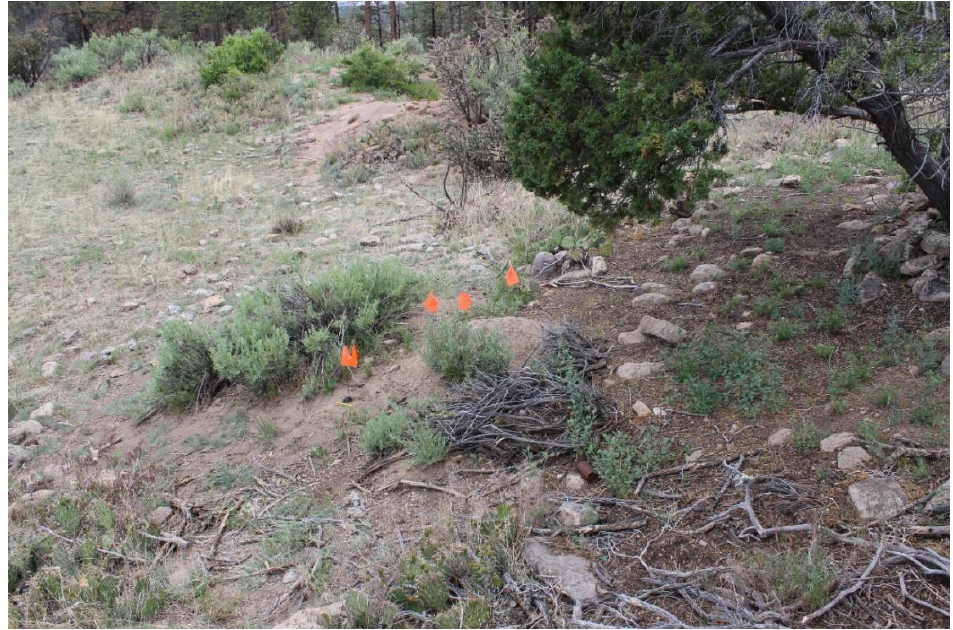
Figure A3. Context photo of one of the ceramic collection locations in the spoil from animal burrowing (UB and UP samples). Orange flags indicate the location of ceramic samples on burrowing spoil from the village room block on the right of the photo. (Photo by C. Roos.)